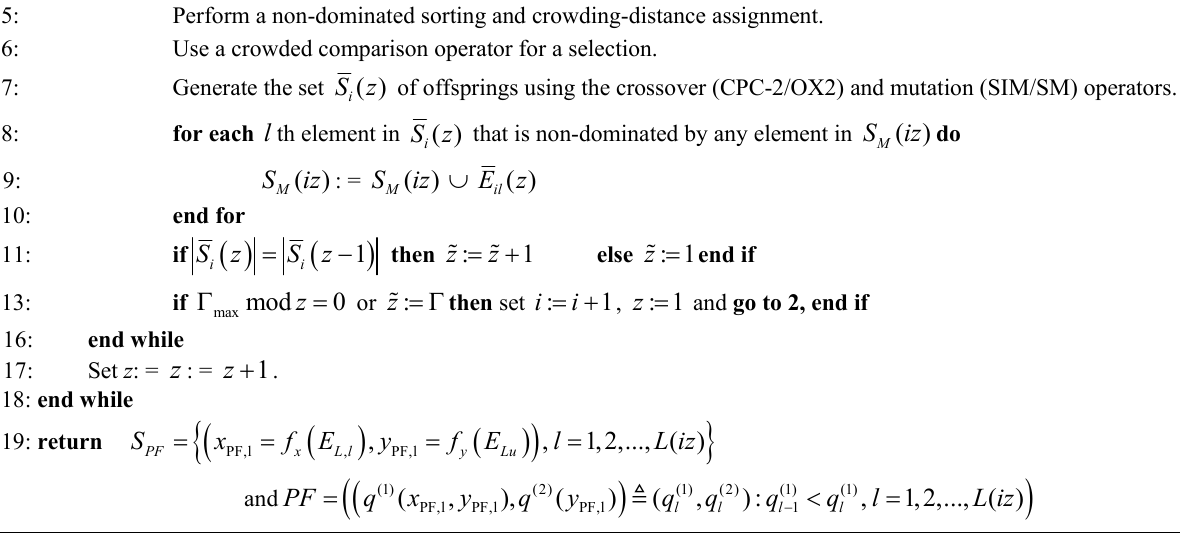
bits equal to 1 and hence